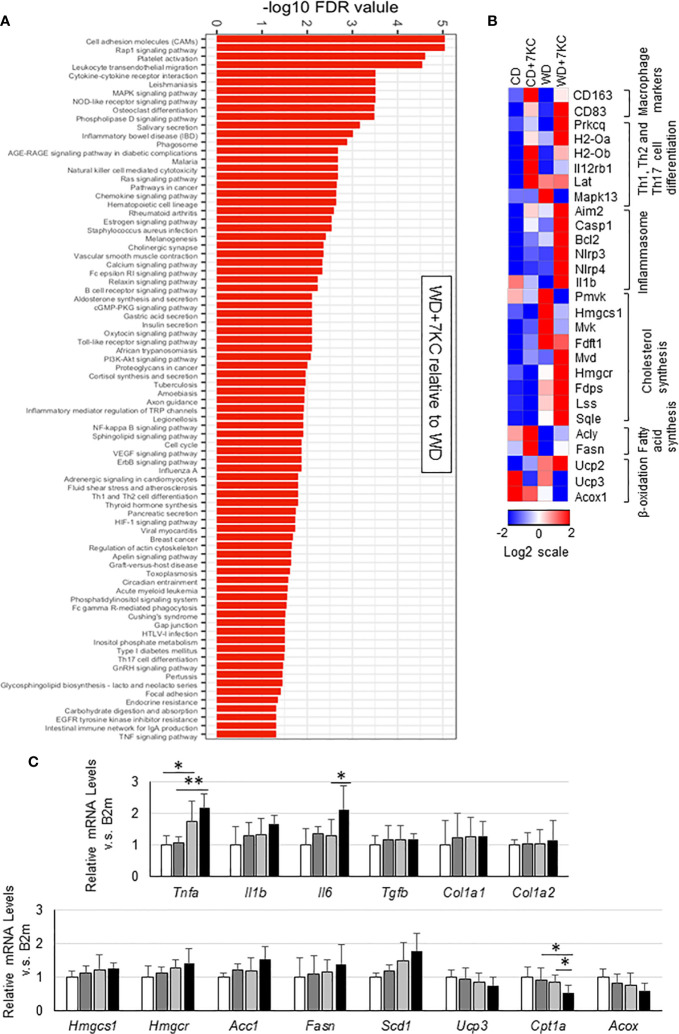
Hepatic gene expression in ob/ob mice fed CD or WD with or without 7KC for 4 weeks. (A) Pathways upregulated by addition of 7KC to WD, (B) Heatmaps from RNA-sequencing analysis, (C) mRNA expressions involved in inflammation and fibrosis, cholesterol synthesis, fatty acid synthesis, and β-oxidation. All values are presented as the means ± SD. ANOVA with Tukey test, n = 6 in (C) *p < 0.05, **p < 0.01.